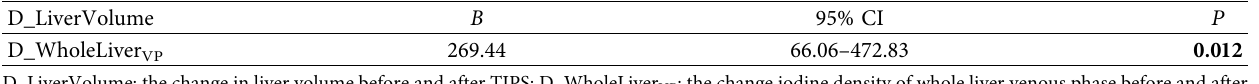
Table 3: Linear regression analysis by the step method to explore the risk factors of the change in liver volume before and after TIPS. D_LiverVolume B 95% CI P D_WholeLiver VP 269.44 66.06–472.83